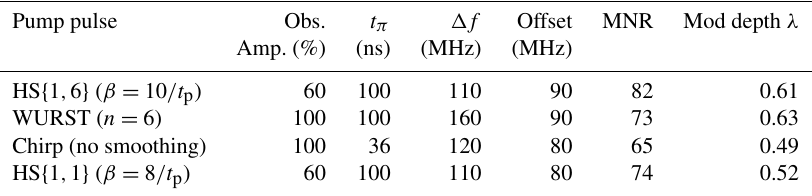
Table 4. The parameters of the observer and pump pulses resulting in the best MNR for each pulse type when the MNR was evaluated up to τ truncation = 2µs. All observer pulses are Gaussian pulses with a pulse length of 74ns for 60% intensity and 56ns for 100% intensity. The observer frequency was 33.93GHz for all pulses.